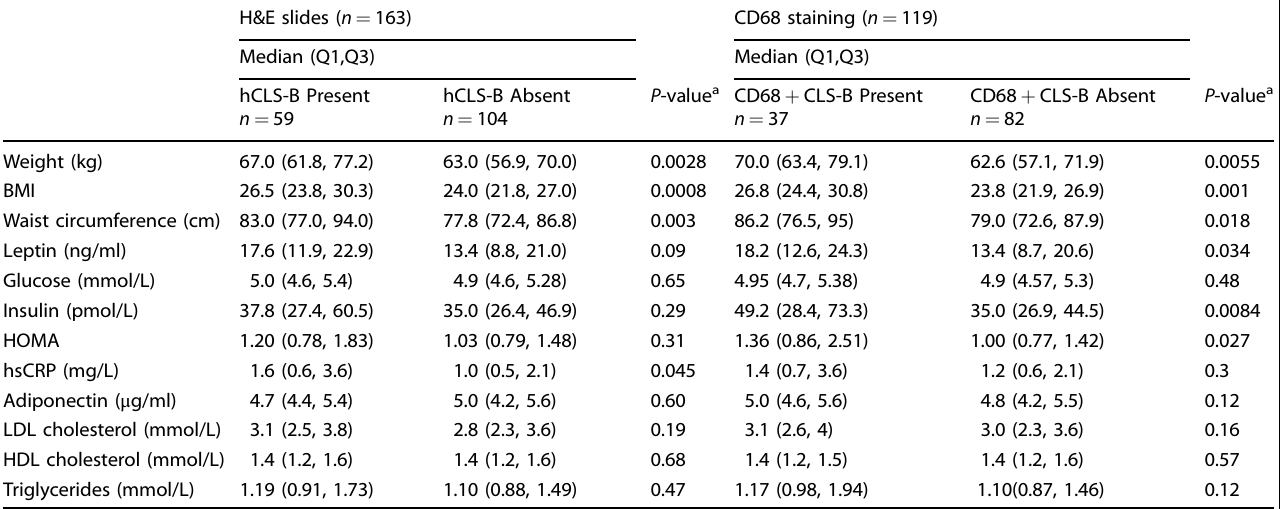
Table 3. Association of hCLS-B and CD68 + CLS-B with body size and metabolic